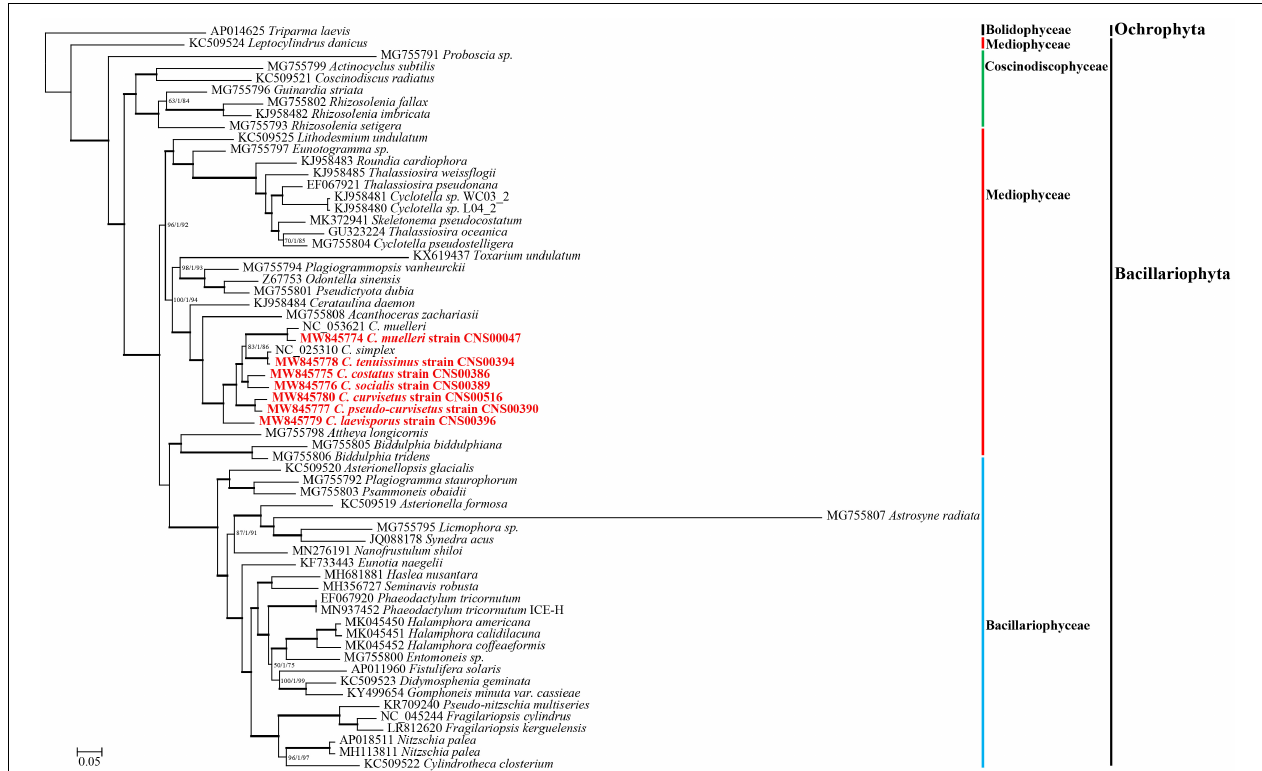
FIGURE 3 | The phylogenetic tree based on concatenated amino acid sequences of 95 shared protein-coding genes using Maximum likelihood (ML) methods. Triparma laevis was used as out-group taxa. Numbers on the branches represent SH-aLRT support (%), aBayes support, and ultrafast bootstrap support (%), respectively. Support values are shown only for branches that did not come with high confidence level (100/1/100). Thick branches indicate high confidence level